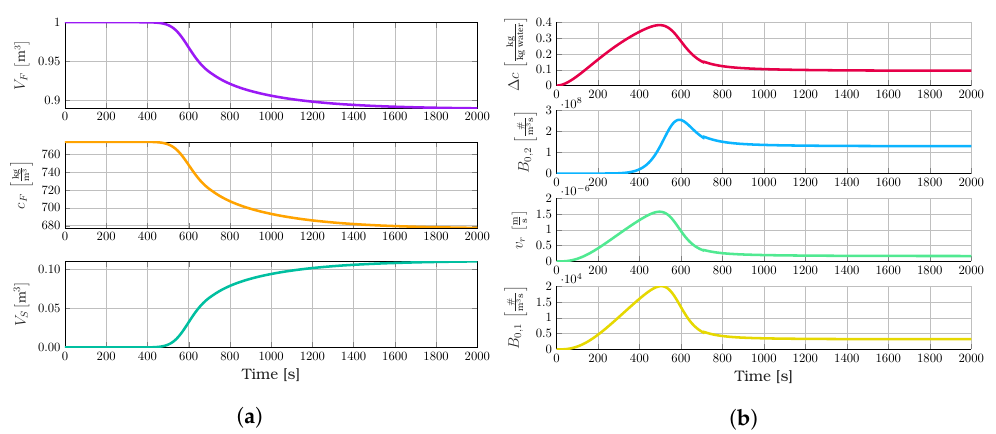
Figure 9. ( a ) The change in V F , c F and V S over time; ( b ) the change in ∆ c , B 0,2 , v r , B 0,1 in the case of the non-isothermal continuous system.